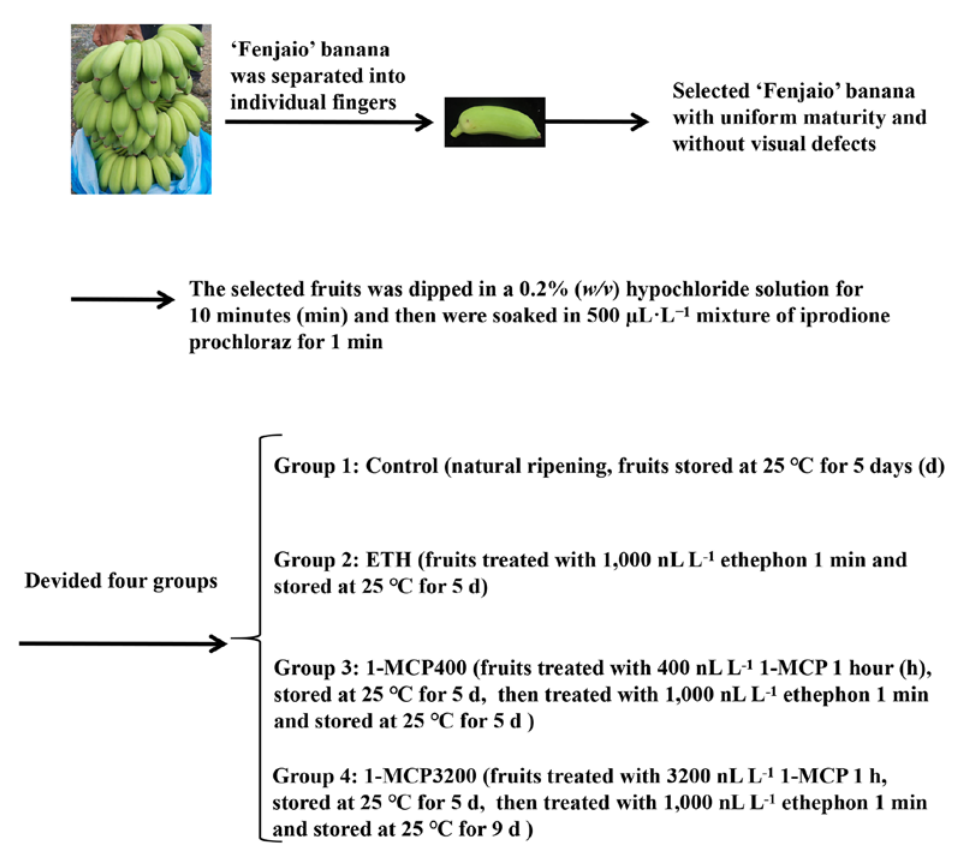
Figure 1. The treatment of ‘Fenjiao’ banana.